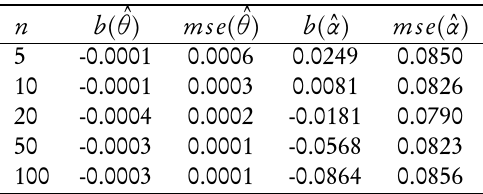
Bias and mean square error of the m.l.e.’s ( ˆ θ , ˆ α ) , for the intermediate binomial distribution